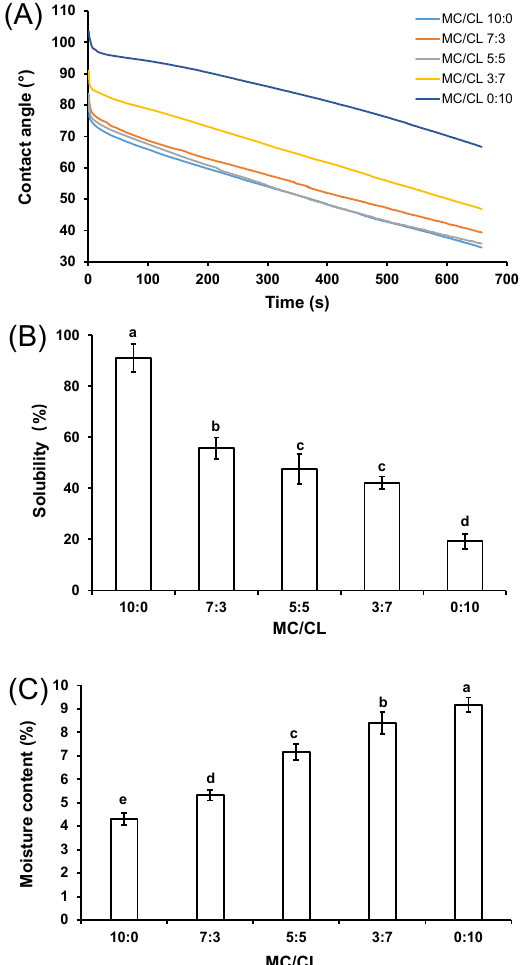
Figure 6. Contact angle ( A ), solubility ( B ), and water content ( C ) of the MC/CL films with different blend ratios. Different letters indicate significant differences ( p < 0.05).